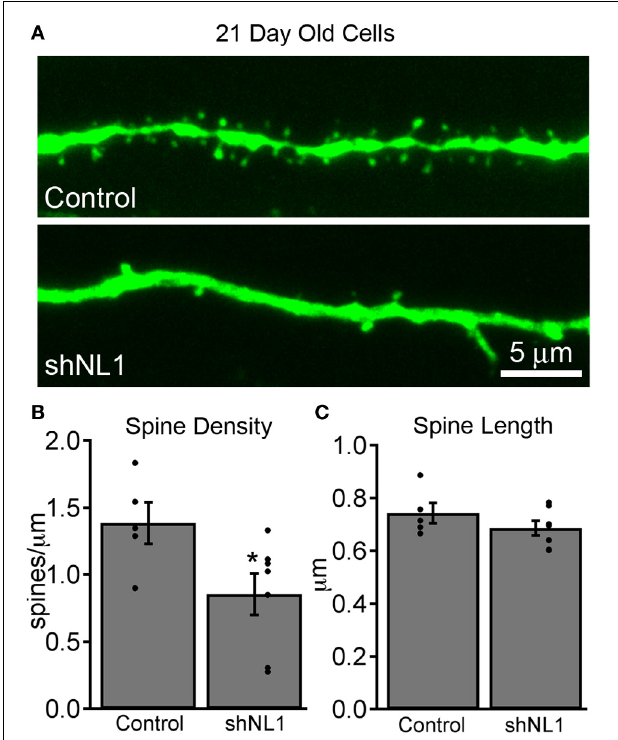
FIGURE 2 | Neuroligin-1 knockdown reduces the density of filopodial spines in 21-day-old adult-born granule cells. (A) Spine head area measurement demonstrating measurement technique (see methods) with spine head areas denoted for selected spines (in μ m 2 ). Scale 2 μ m. (B) Histogram of spine density (spines per μ m dendrite length) at 21 days post-mitosis for each condition, demonstrating a selective decrease in the density of small spines/filopodia ( p < 0 . 05, K–S test). (C) Histogram of spine density (spines per μ m dendrite length) at 28 days post-mitosis for each condition ( p < 0 . 05, K–S